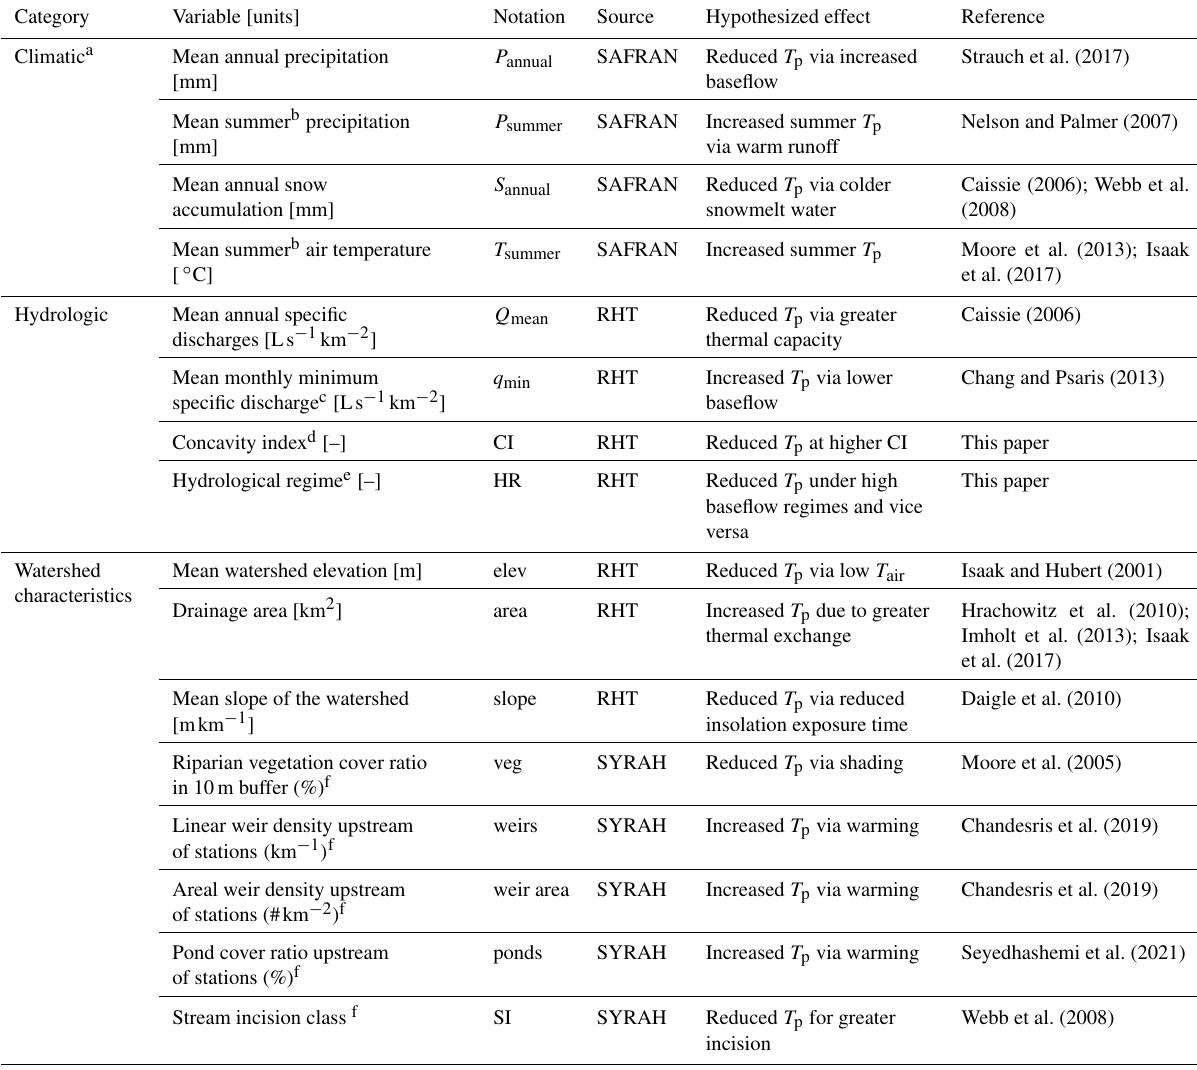
Table 3. List of explanatory variables used in models and hypothesized effects on thermal